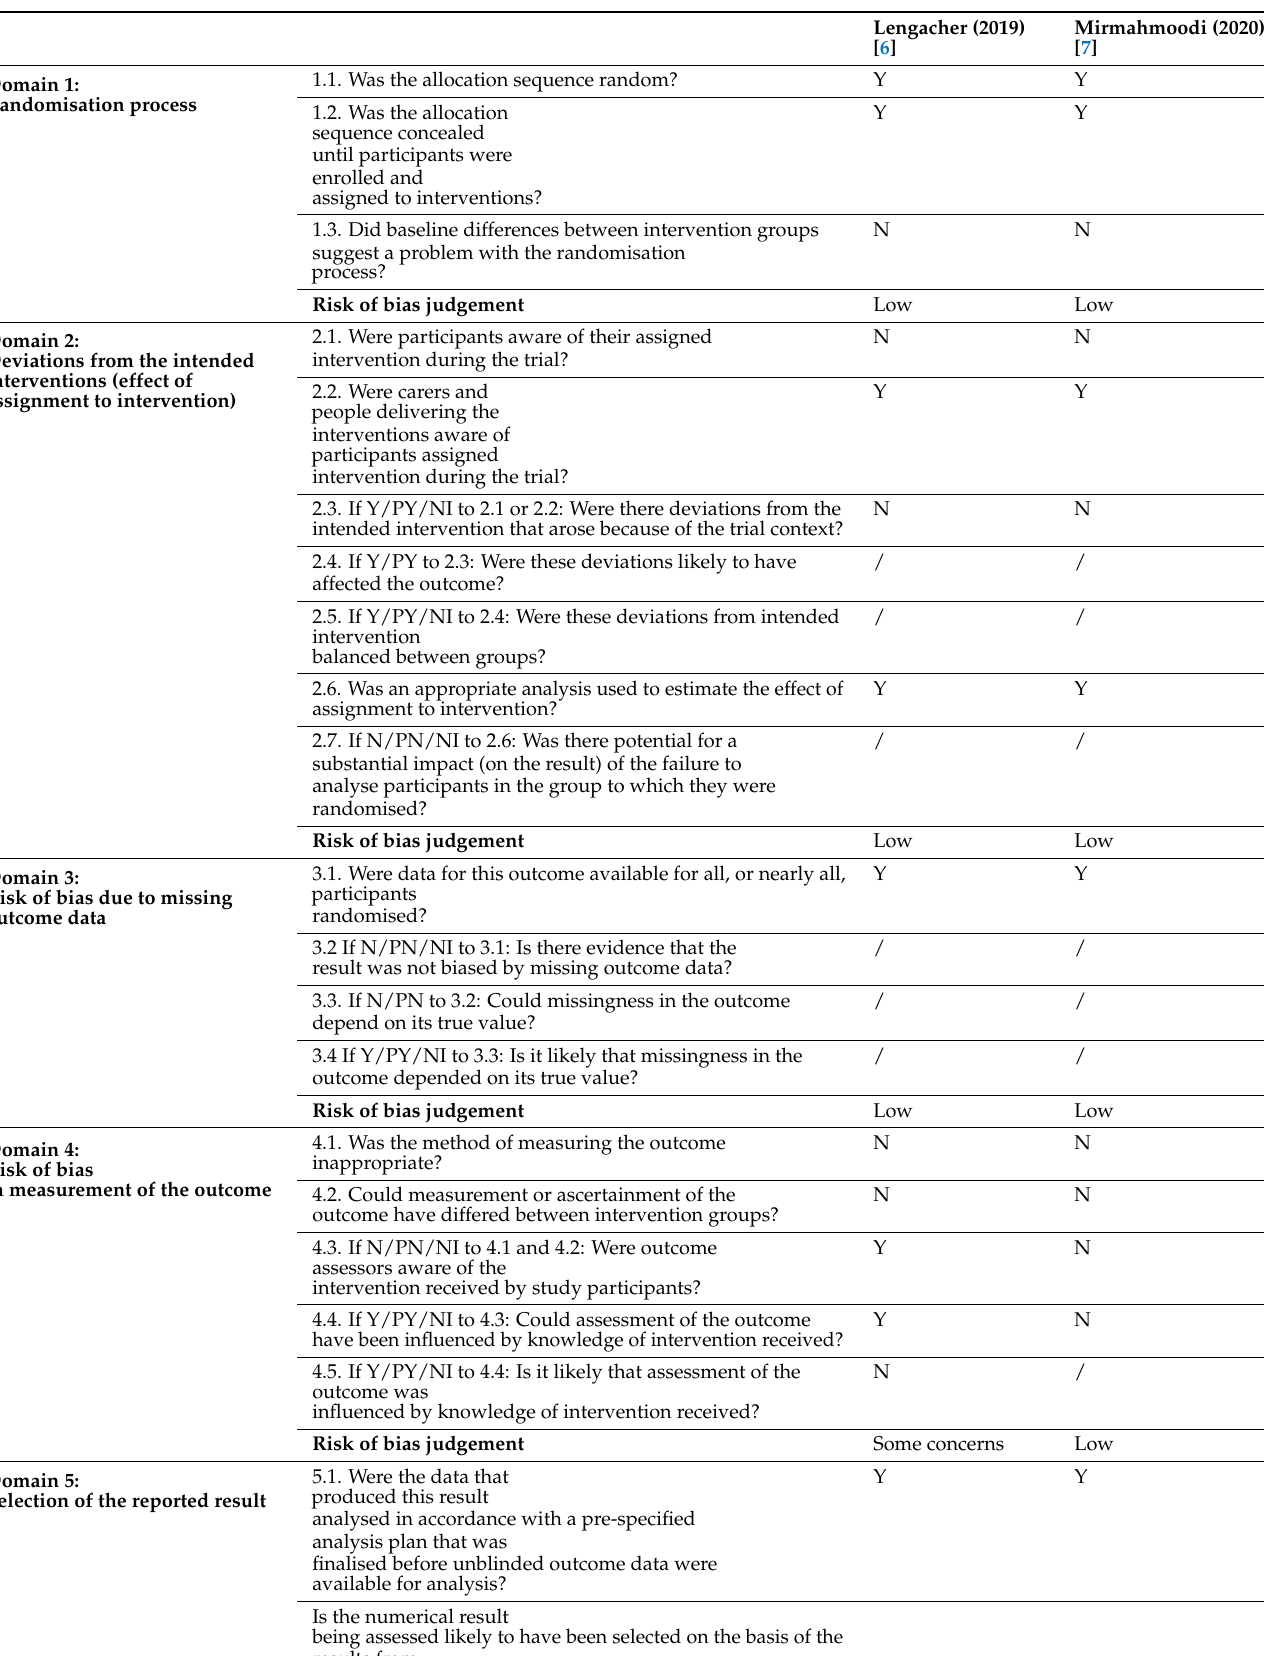
Table 4. RoB 2 (modified)